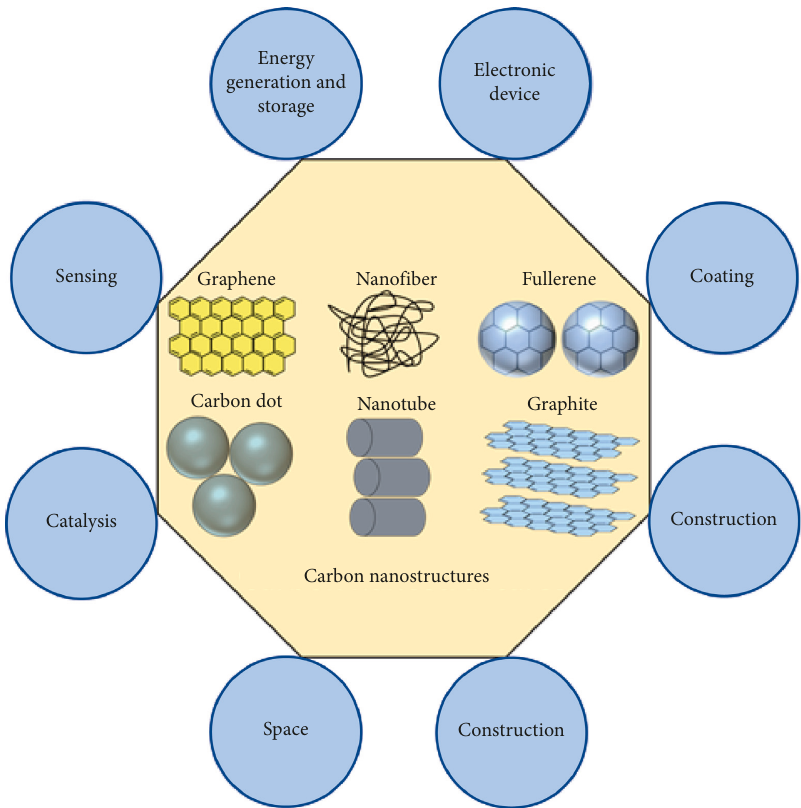
Figure 1: Applications of carbon